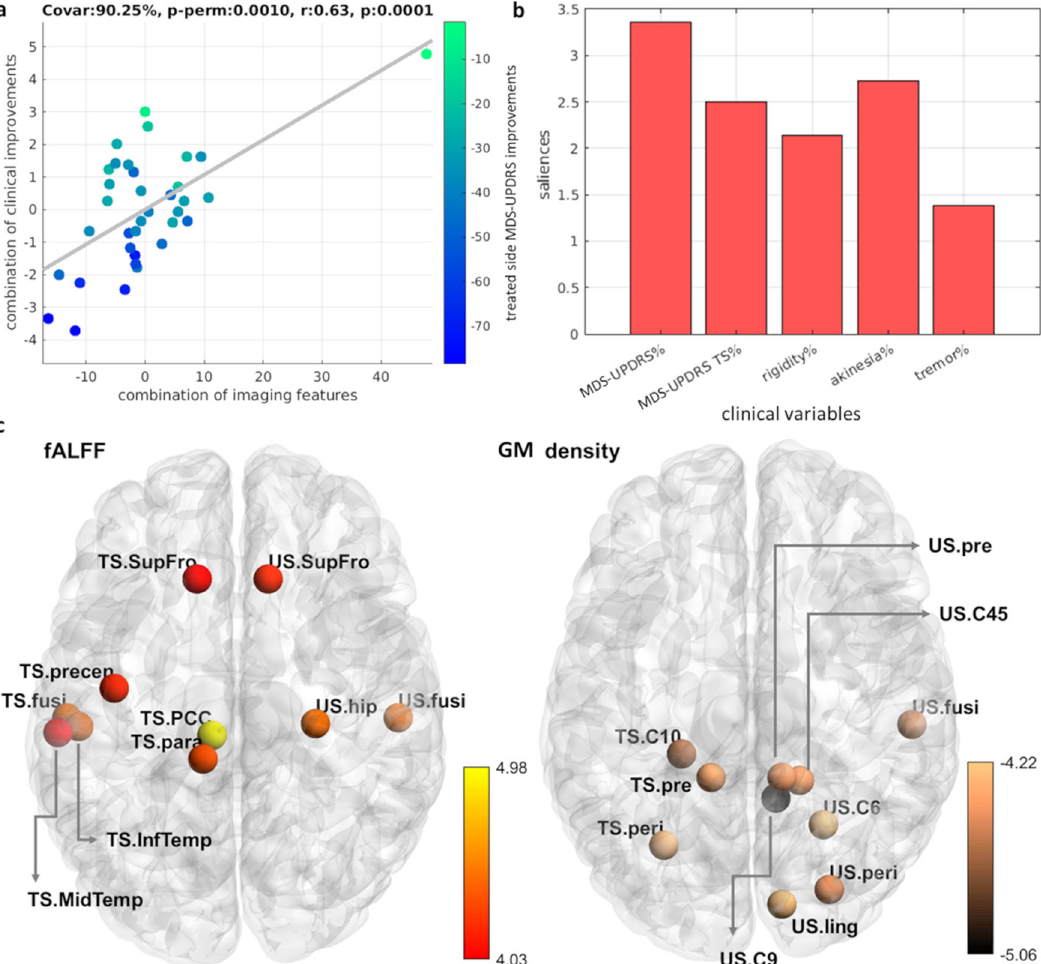
Fig. 4 Longitudinal brain changes associated with tcMRgFUS-subthalamotomy clinical outcomes. a PLS-LV component explains 90.25% of the common imaging-clinical covariance. Each dot represents one subject color-coded with the total MDS-UPDRS changes in percent. b Contribution (i.e. bootstrapping ratio) of the fi ve clinical outcome measures in the association with the longitudinal neuroimaging changes. c Contributions of the top 5% brain regional longitudinal changes after treatment. Changes in fALFF and gray matter density are shown in the left and right, respectively. [fALFF fractional amplitude of low-frequency fl uctuation, TS treated side, US untreated side, GM gray matter; the full name of each region is included in Supplementary Table